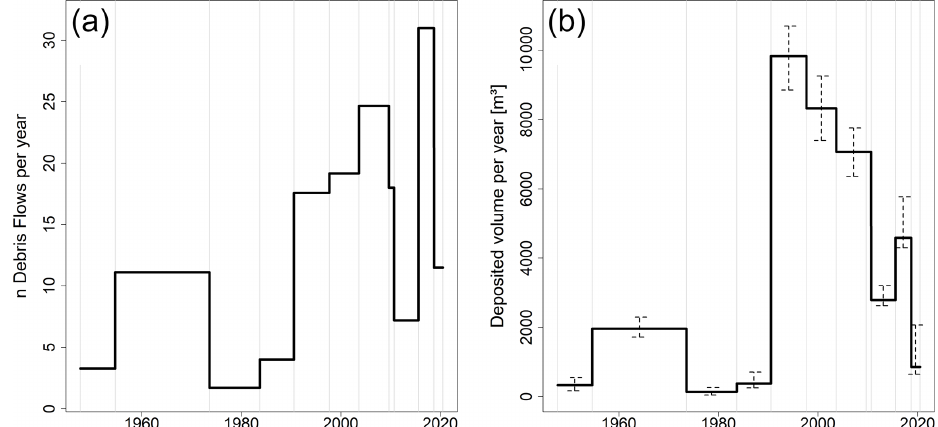
Figure 6. Temporal variations of slope-type debris flow activity in Horlachtal since 1947. (a) The number of mapped slope-type debris flows per year. (b) The deposited volume of slope-type debris flows per year. Uncertainties of the calculations are added for each time span. The light grey vertical lines in both panels represent the acquisition dates of the used orthophotos.